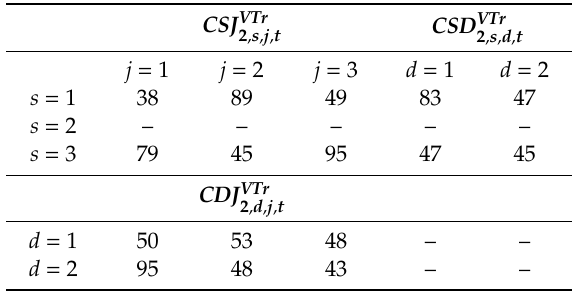
Table A8. Variable transportation cost per unit of product 2 ( € ) (considered here the same for any t ).